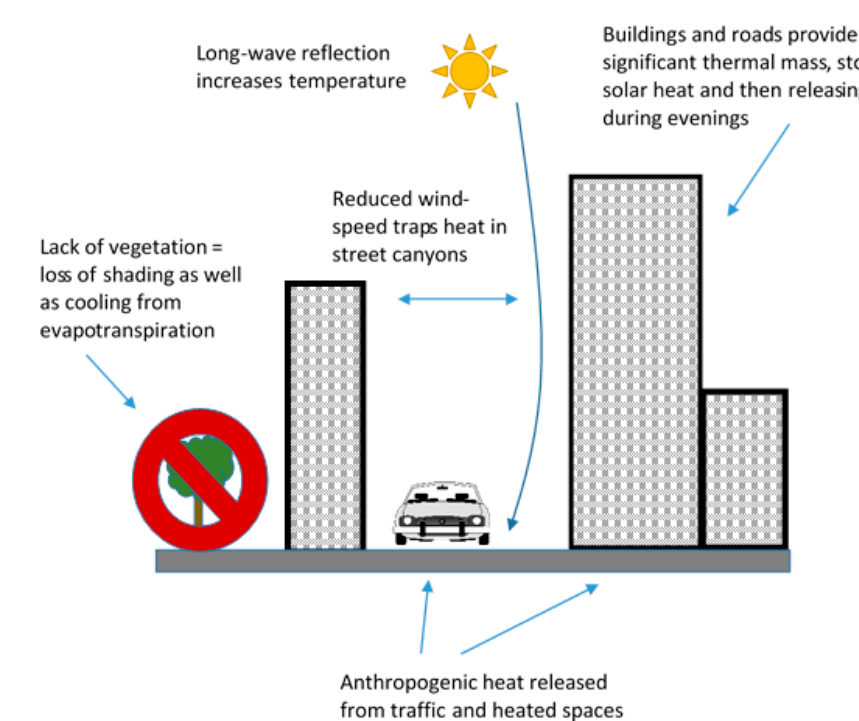
Figure 4. Contributions to Urban Heat Island (UHI) from multiple sources, including a lack of vegetative cover and reduced evapotranspiration.